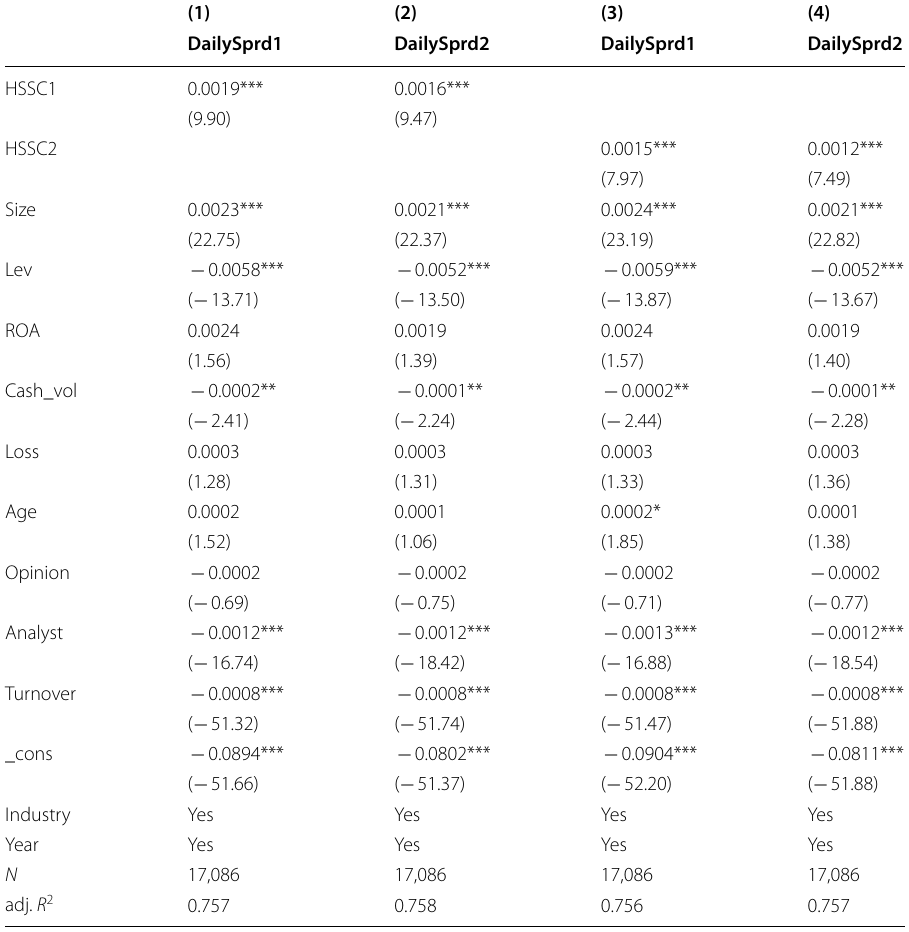
Table 10 Robustness checks: alternative measures of stock market